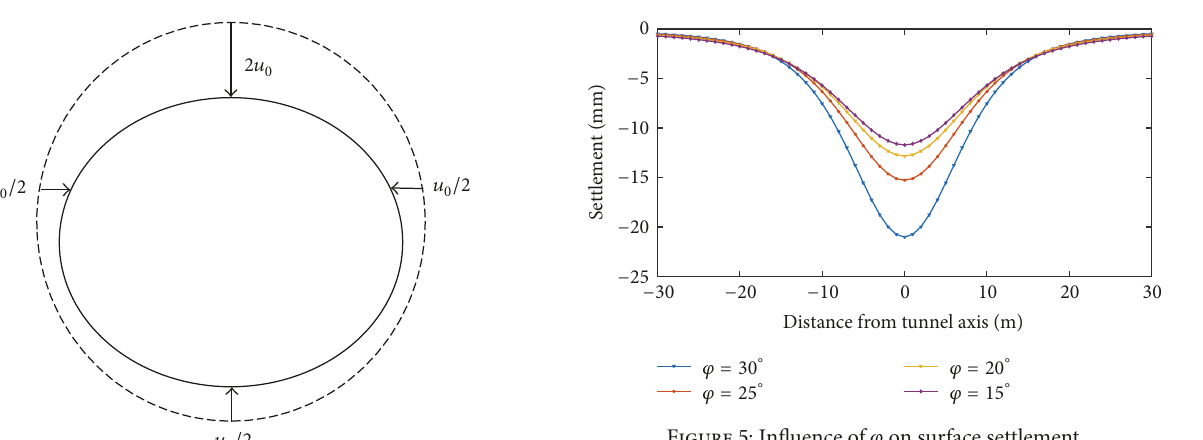
Figure 5: Influence of 𝜑 on surface settlement.